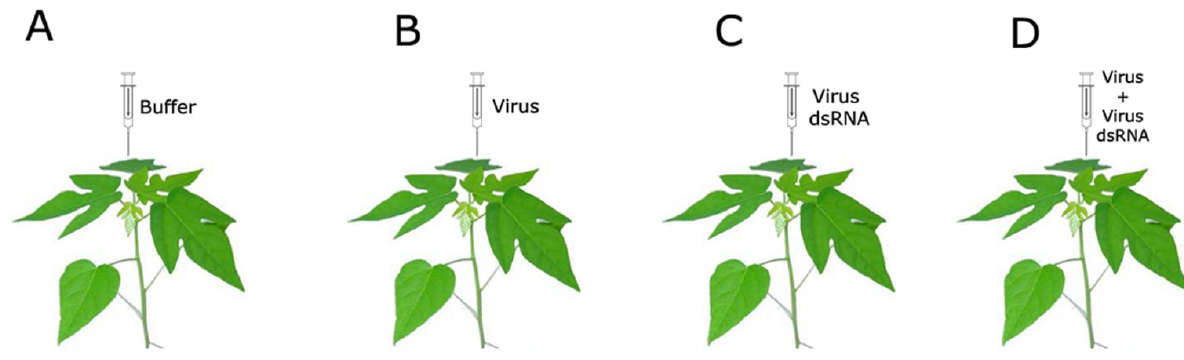
Figure 5. Induced resistance in papaya by viral dsRNA inoculation. Papaya seedlings were inoculated with ( A ) buffer (control); ( B ) PMeV; ( C ) PMeV dsRNA and ( D ) PMeV and PMeV dsRNA. A delay in the infection process occurred in the plants simultaneously inoculated by PMeV and PMeV